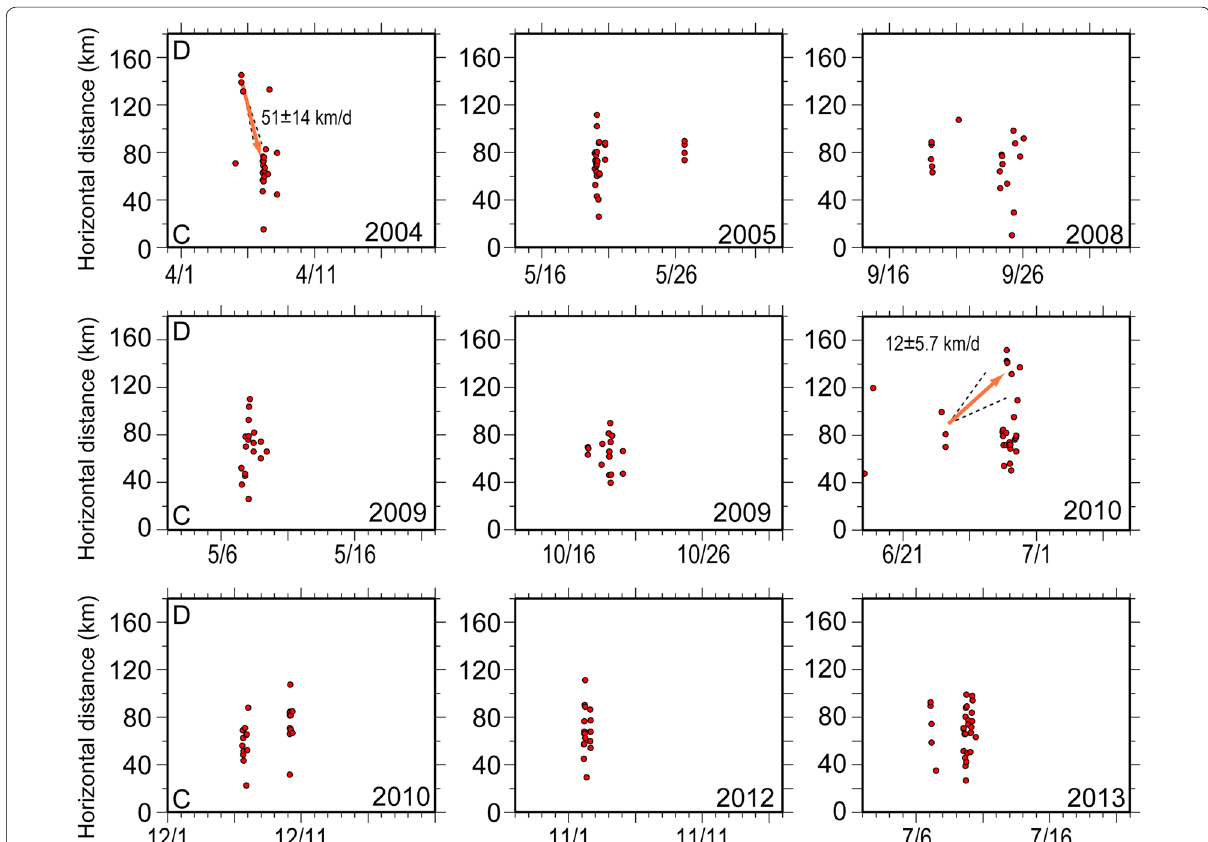
Fig. 9 Time–space plot of low-frequency earthquake (LFE) swarm in the Okinawa area. The swarm is plotted when the number of events was >18. The plotted area and annotations of C and D are denoted in Fig. 6b. Red circles show the LFEs. Arrows and dotted lines show the direction of LFE migration and its error range,